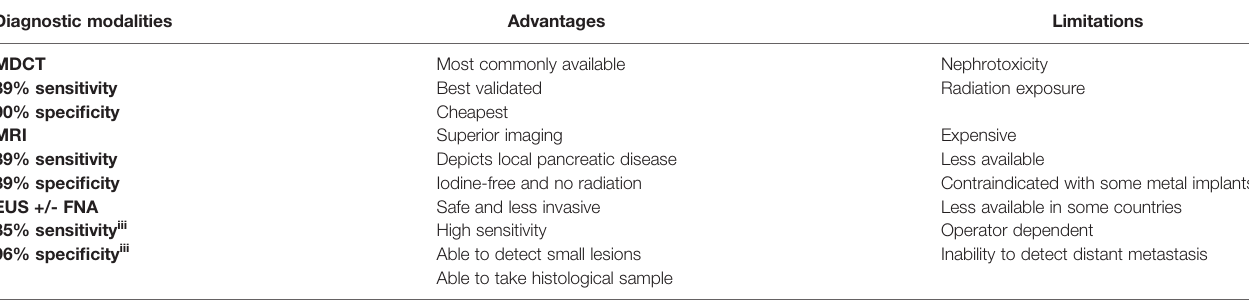
TABLE 1 | Bene fi ts and limitations of pancreatic cancer diagnostic modalities i, ii